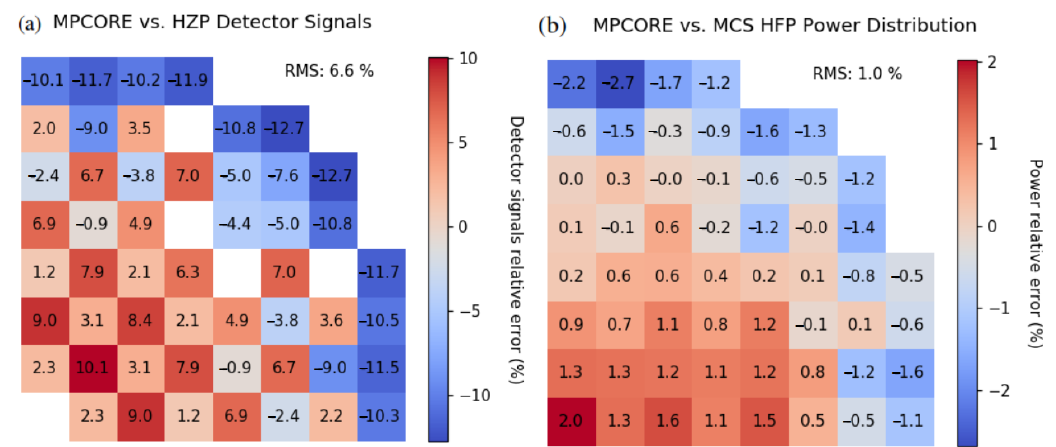
Figure 3. Radial distribution of errors at the beginning of cycle: ( a ) detector signals compared to measurements; ( b ) assembly-wise power compared to